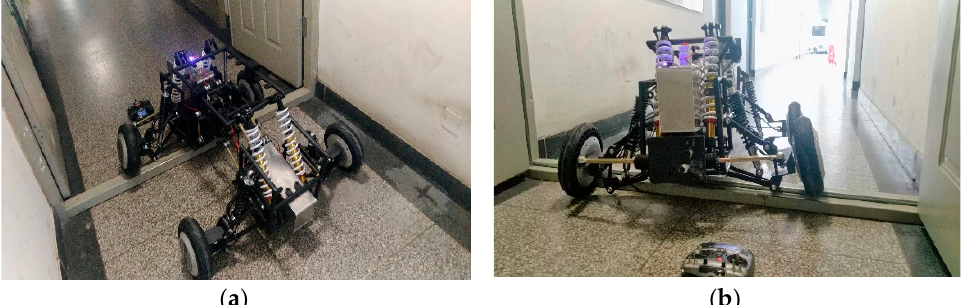
Figure 31. Vehicle crossing beam test. ( a ) Top view of vehicle crossing beam ( b ) Front view of vehicle crossing beam